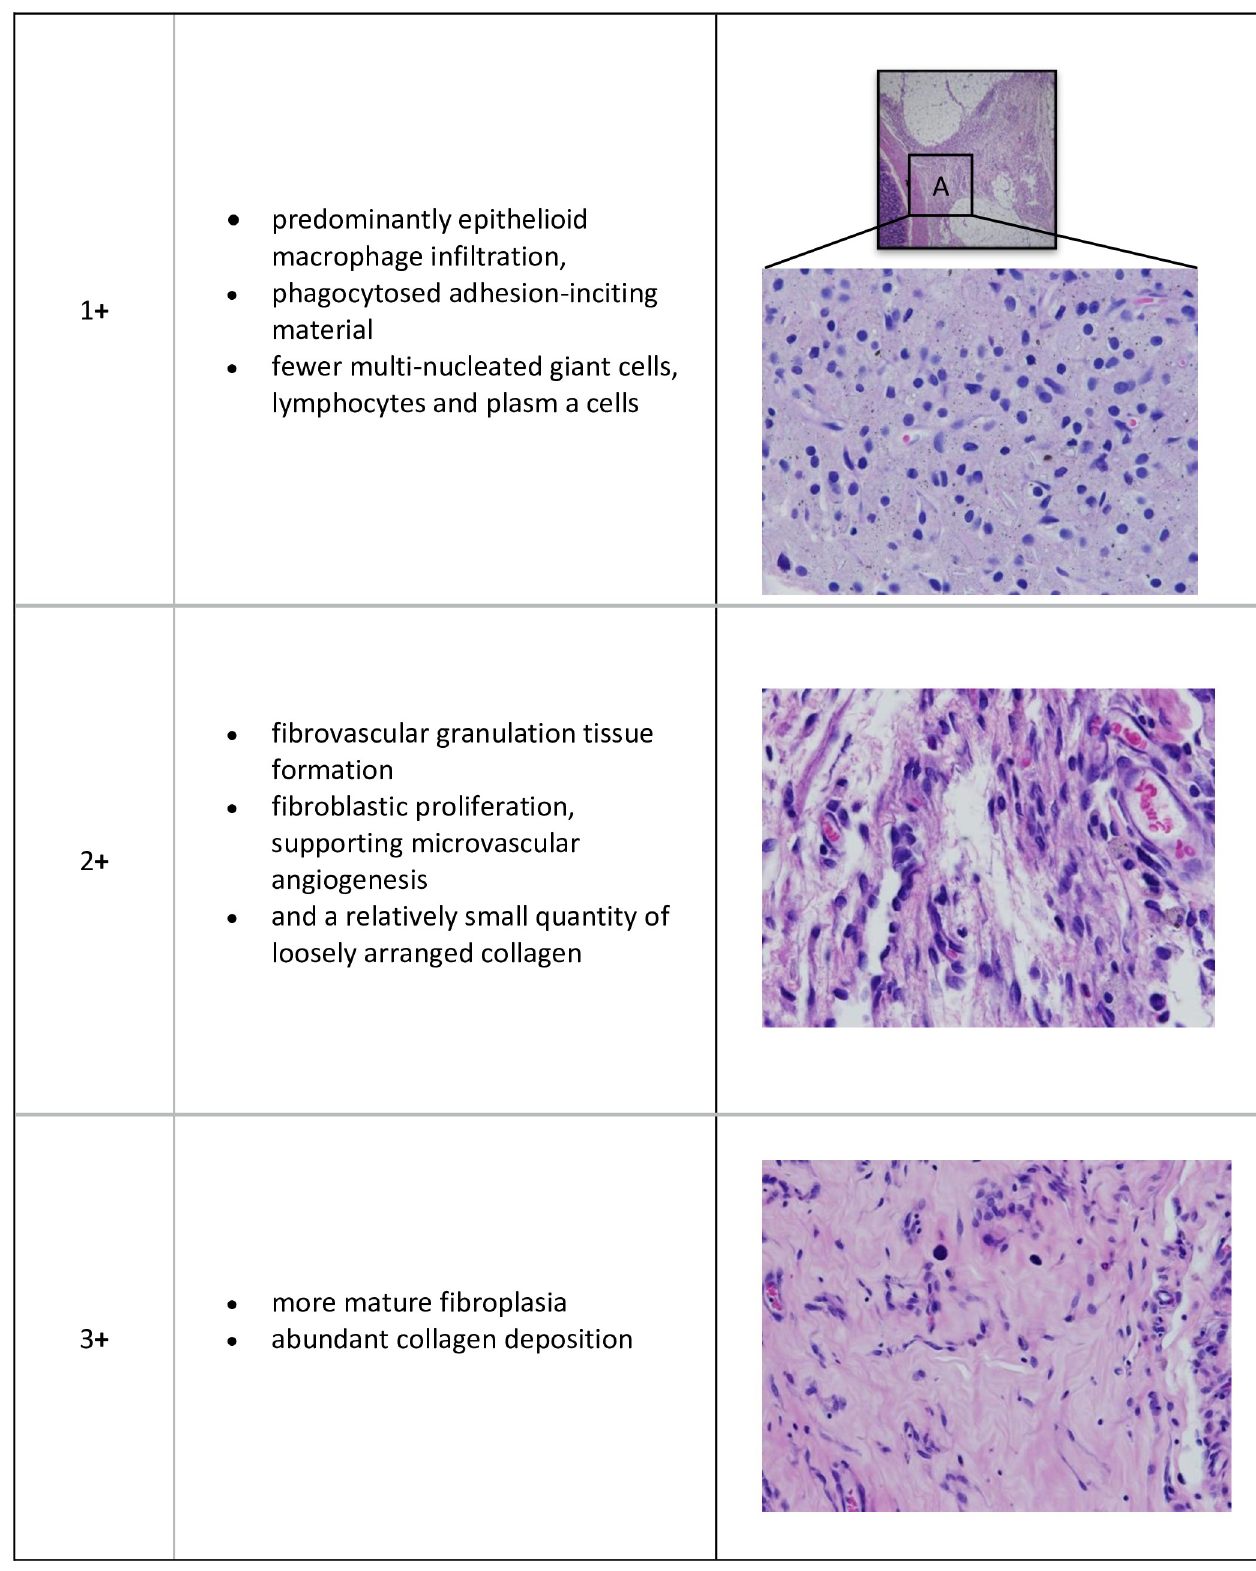
Fig 2. H & E grading of caecal scar tissue 20X.